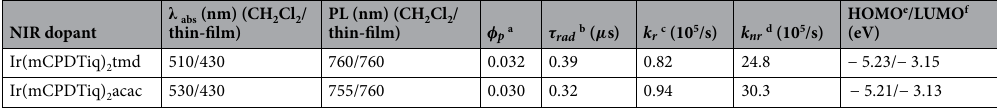
Table 1. Photophysical properties of Ir(mCPDTiq) 2 tmd and Ir(mCPDTiq) 2 acac. a PLQY was measured in vacuum-deposited thin-film (50 nm). b Radiative decay rate measured in dichloromethane (DCM) . obtained through E g and HOMO level.